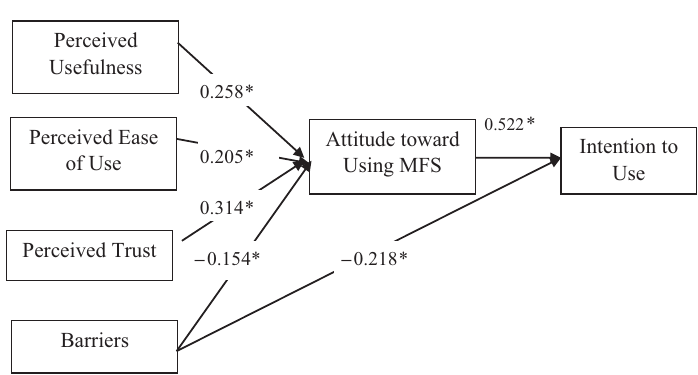
Table 5. Hypothesis testing (direct effects)